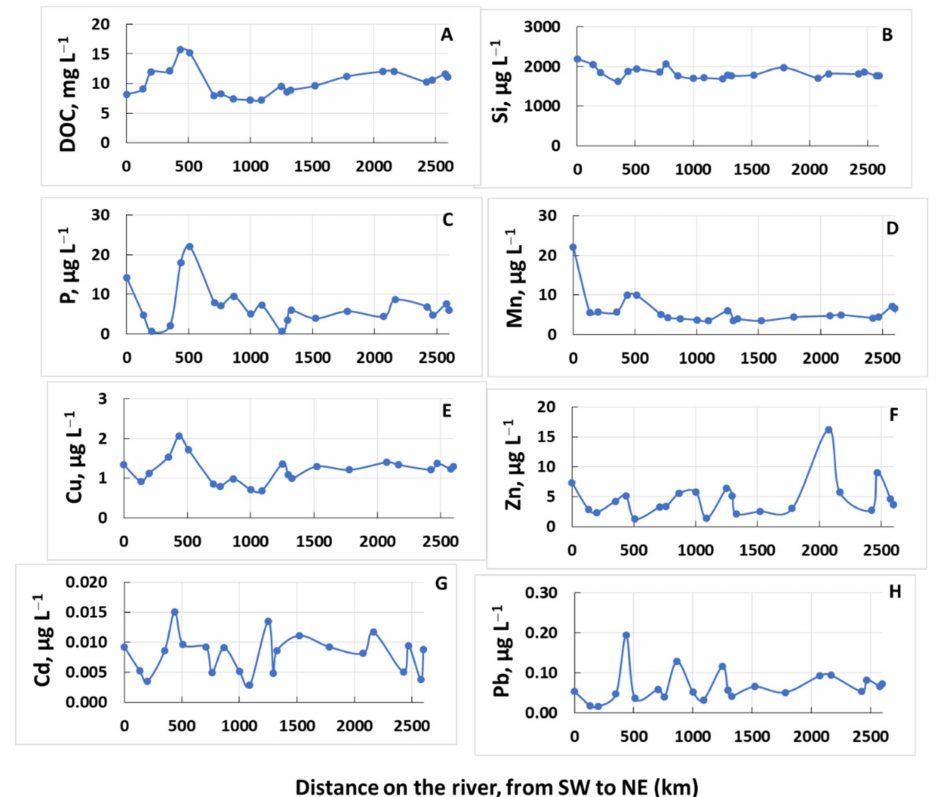
Figure 4. Examples of elements not exhibiting any concentration trend in the main stem of the Lena River from SW to NE: DOC ( A ), Si ( B ), P ( C ), Mn ( D ), Cu ( E ), Zn ( F ), Cd ( G ) and Pb ( H ). The distance is measured in km of river from Zhigalovo (0 km, upper reaches) to the Aldan River (2600